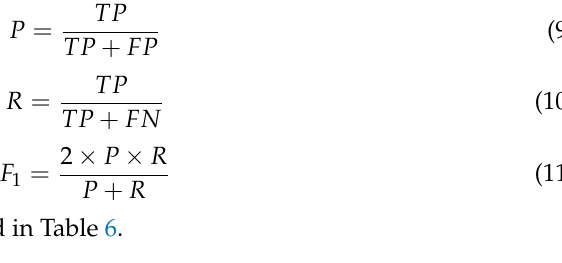
Table 6. Definition of TP , FP , FN and TN